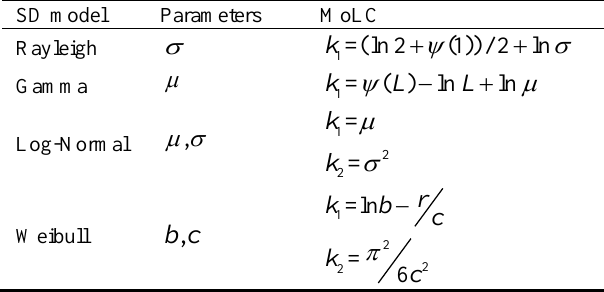
Table I. Statistical distribution model parameter estimation.